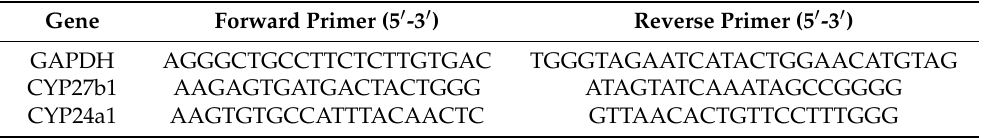
Table 2. Sequences of primers used for RT-PCR in renal tissue.